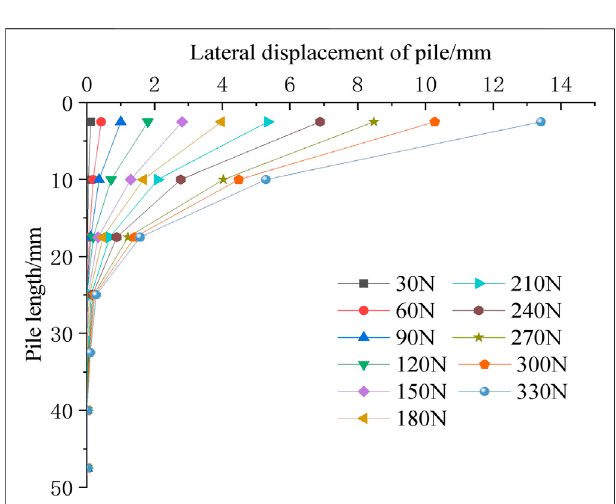
FIGURE 10 | Pile lateral displacement diagram under horizontal static